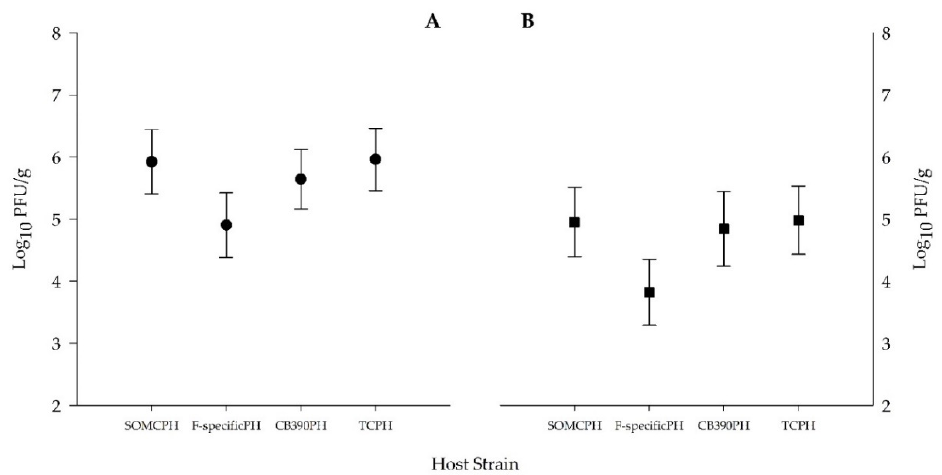
Figure 2. SOMCPH, F-specificPH, CB390PH, and TCPH concentrations in sludge samples without treatment ( A ) and with treatment ( B ). SOMCPH: Somatic Coliphages, F-specificPH: F-specific Coliphage, PHCB390: CB390 phages, TCPH: Total Coliphages .